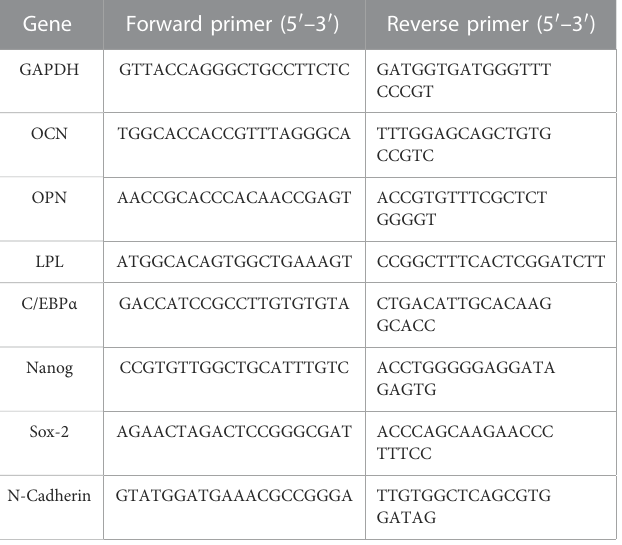
TABLE 1 Primers used for quantitative RT-PCR. Gene Forward primer (5 ′ – 3 ′